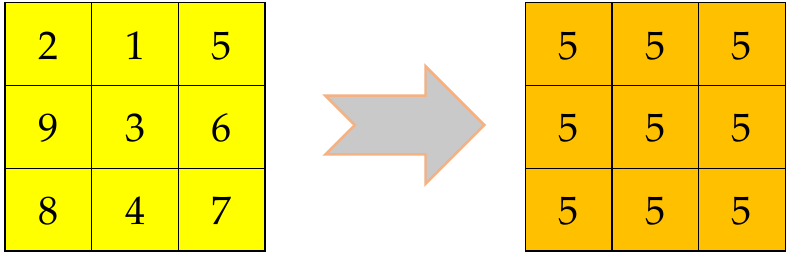
Figure 2. Mean filtering model (3 × 3 matrix).